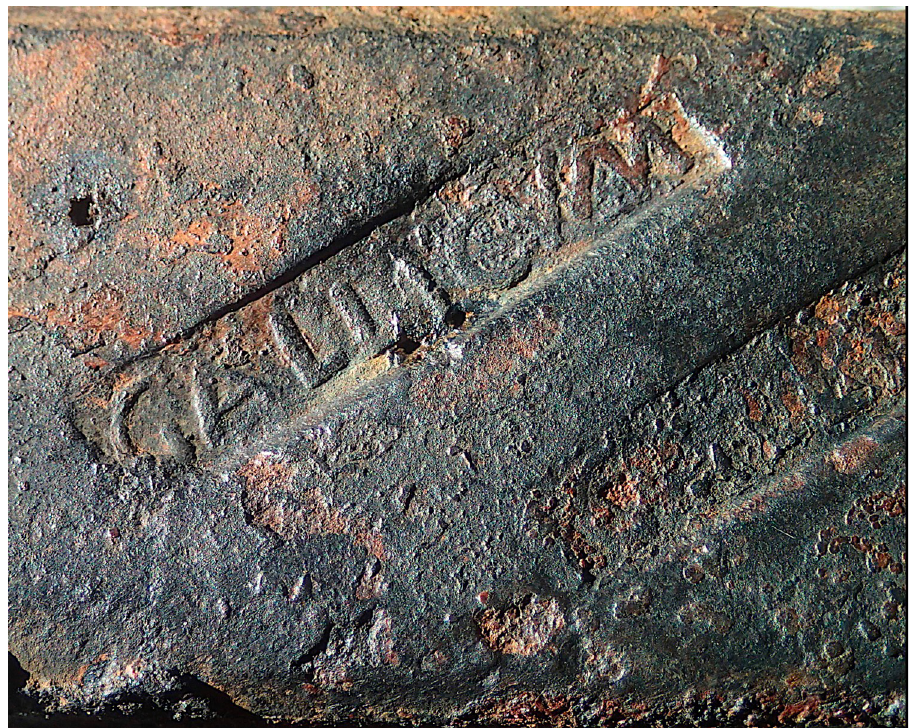
Fig 27. GALLICUM stamp discovered by Luc Long on a 2M-type bar from the SM33 wreck off Saintes-Maries-de- la-Mer.